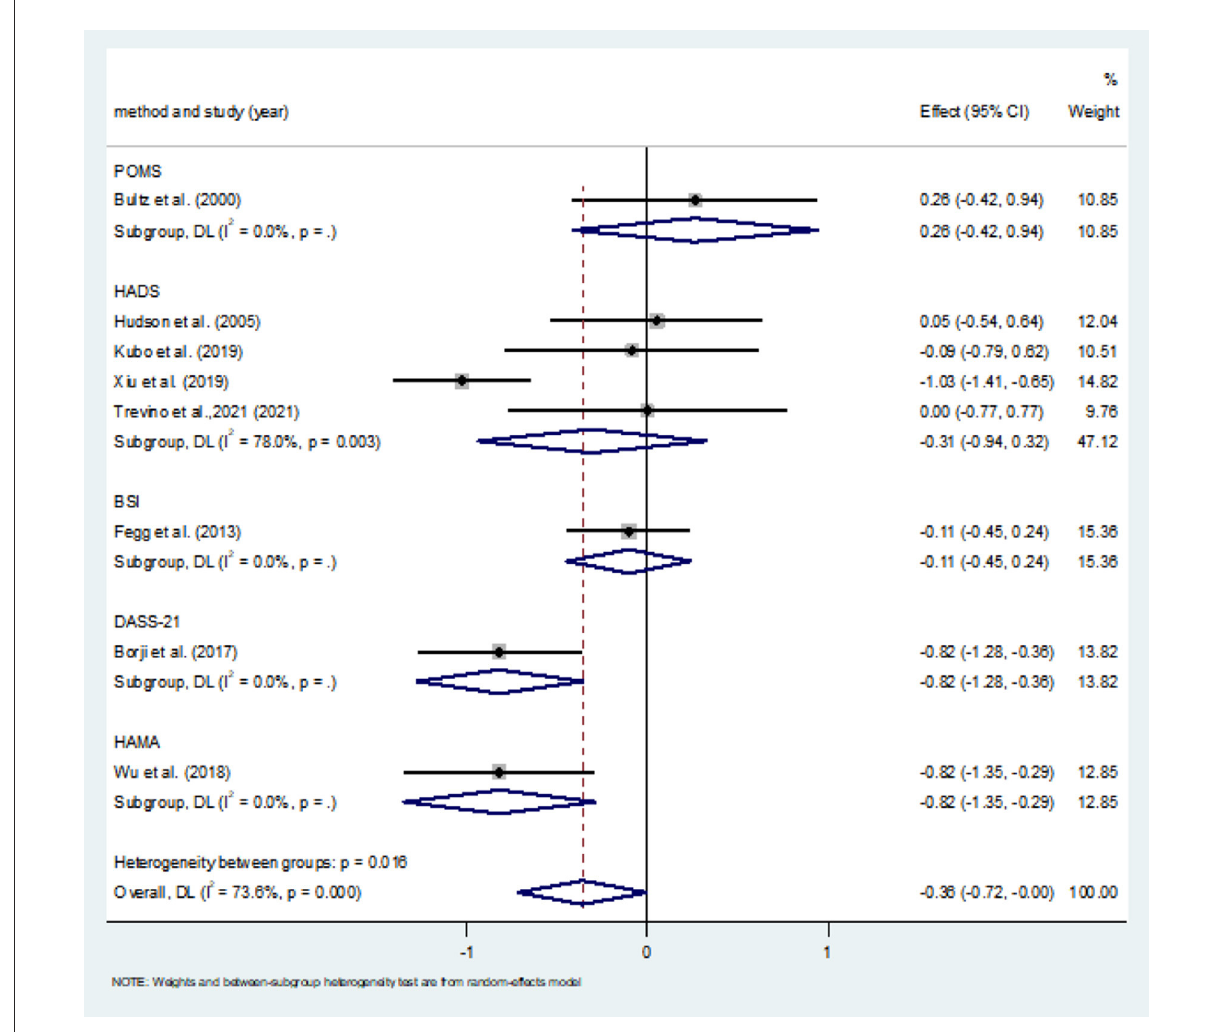
FIGURE9 Forest maps for subgroup analysis of effects on